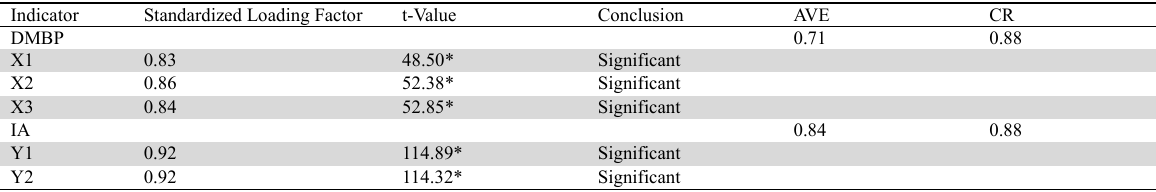
Measurement model evaluation